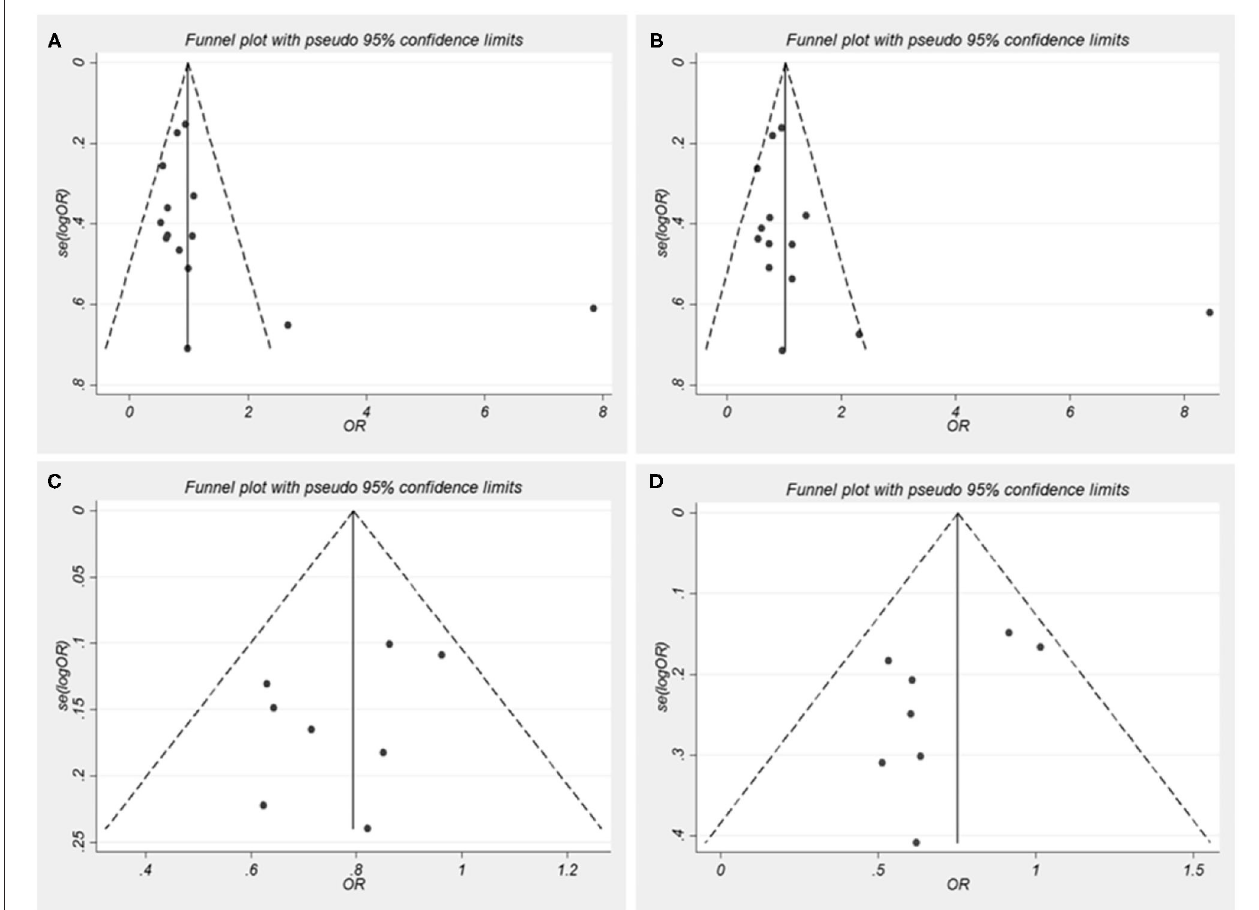
FIGURE 2 | Funnel plots for nucleotide oligomerization domain-like receptor family pyrin domain-containing 3 (NLRP3) single nucleotide polymorphisms (SNPs) and autoimmune diseases (AIDs) risk. OR, odds ratios. (A) A vs. C for rs35829419; (B) AA/AC vs. CC for rs35829419; (C) G vs. C for rs10754558; (D) GG/GC vs. CC for